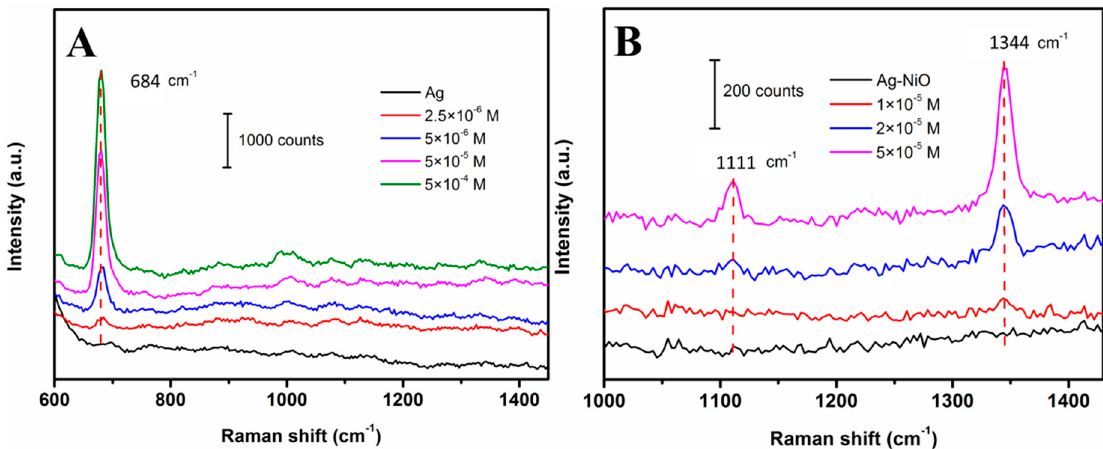
Figure 7. SERS spectra with various concentrations of ( A ) melamine recorded on porous Ag and ( B ) methyl parathion recorded on Ag-NiO nanofibers, respectively.